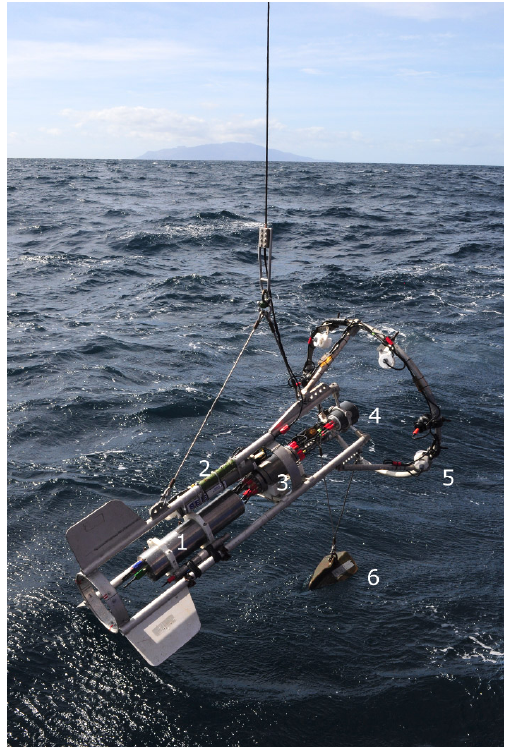
Figure 1. (a) The Pelagic In Situ Observations System (PELA- GIOS) with battery (1), CTD (2), telemetry (3), camera (4), LEDs (5), and depressor (6) during deployment from R/V Poseidon in February 2018 (photo: Karen Hissmann).